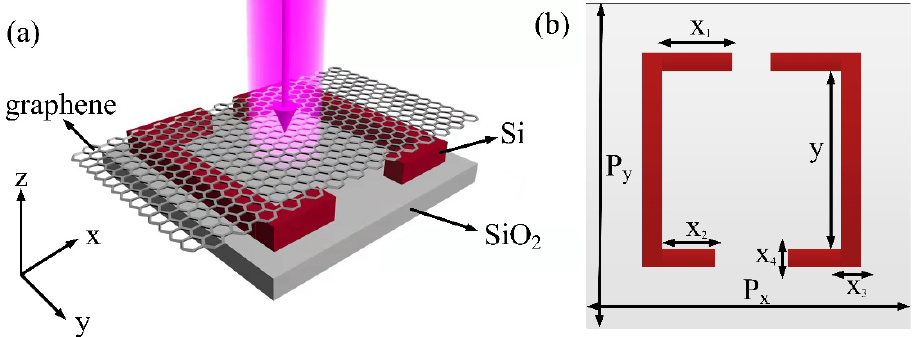
Figure 1. ( a ) Schematic diagram of the hybrid graphene-dielectric metasurface. ( b ) Top view of a unit with dimensions specified.